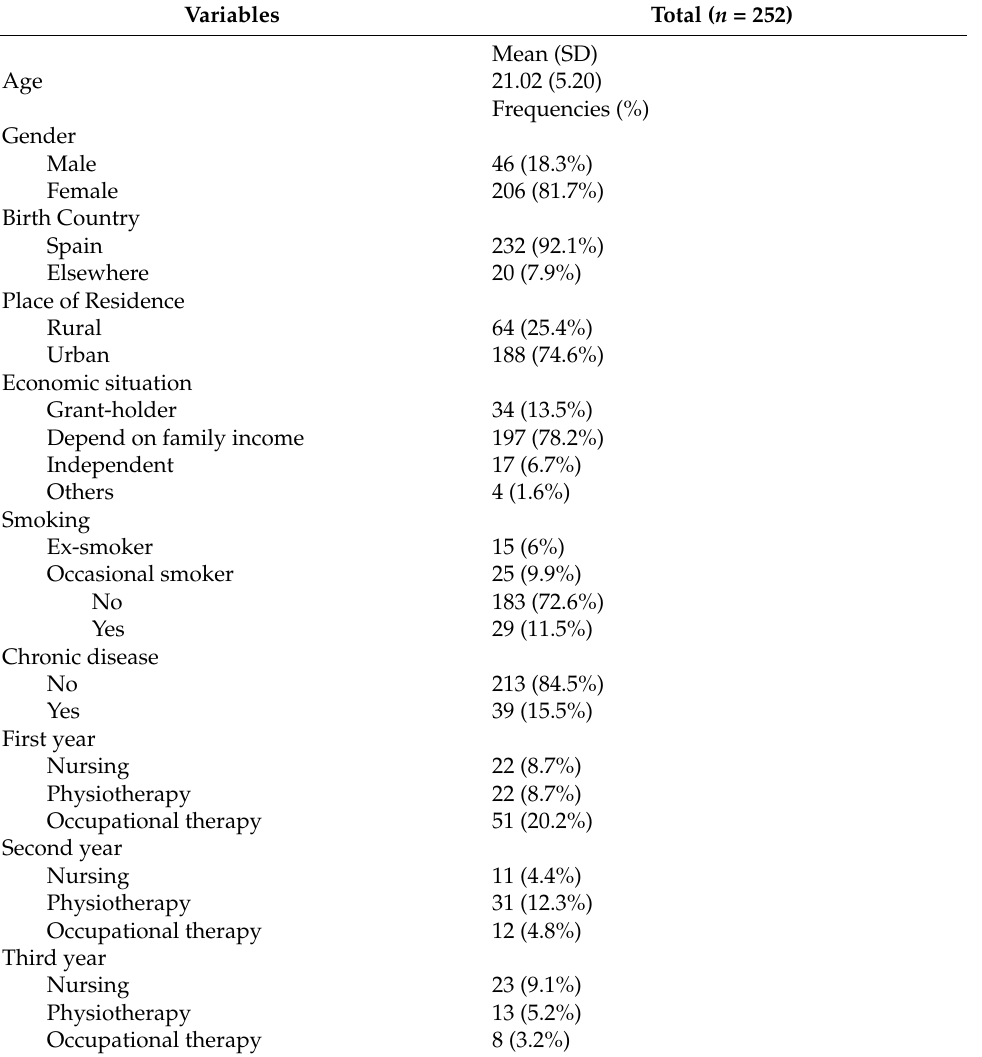
Table 1. Socio-demographic characteristics of the study